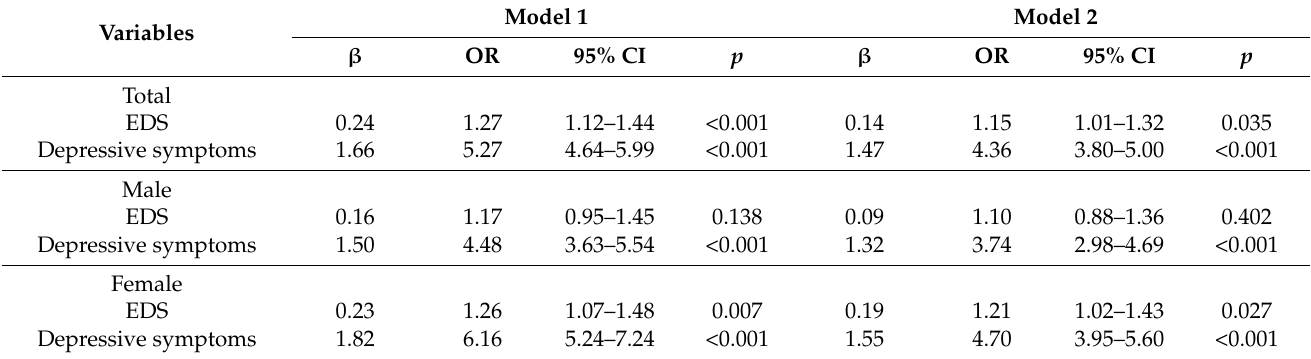
Table 2. Associations between excessive daytime sleepiness, depressive symptoms, and suicidal